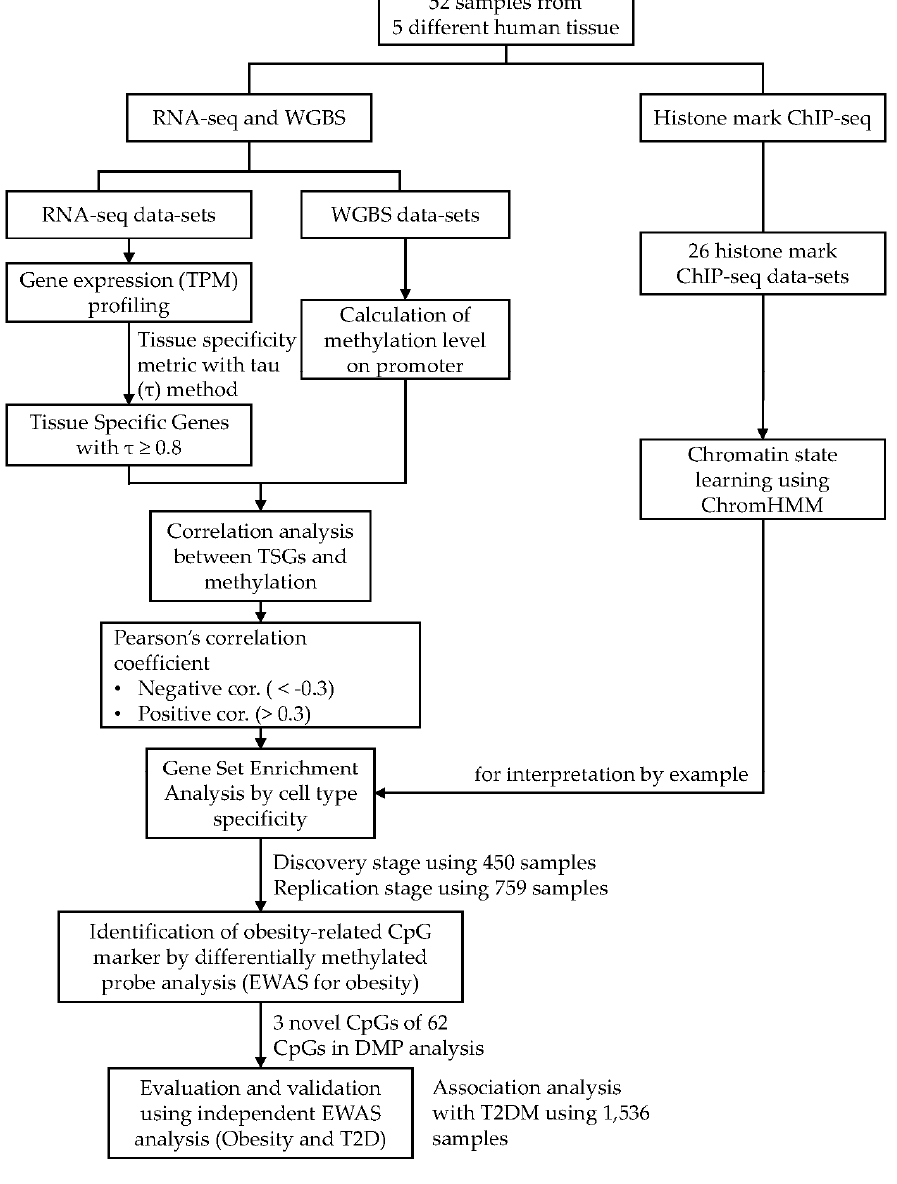
Figure 4. Schematic workflow.